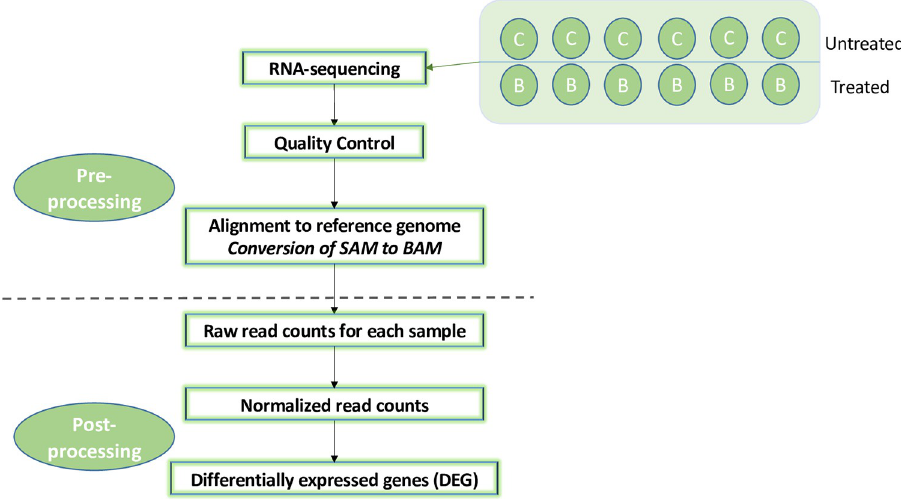
Fig 1. Flowchart of the transcriptomic data analysis pipeline in 6 lymphoblastic cell lines with and without in vitro busulfan treatment. Legend: BAM, Binary Alignment Map; DEG, differentially expressed genes; RNA, ribonucleic acid; SAM, Sequence Alignment Map; WES, whole-exome sequencing.